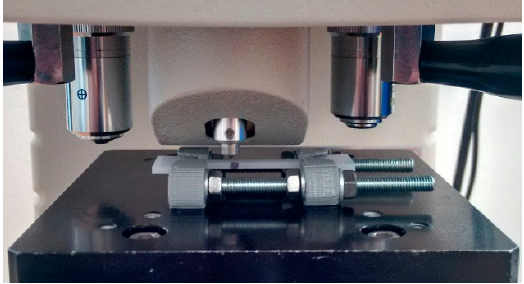
Figure 7. Measurement of microhardness of a deformed polymer subjected to tension.